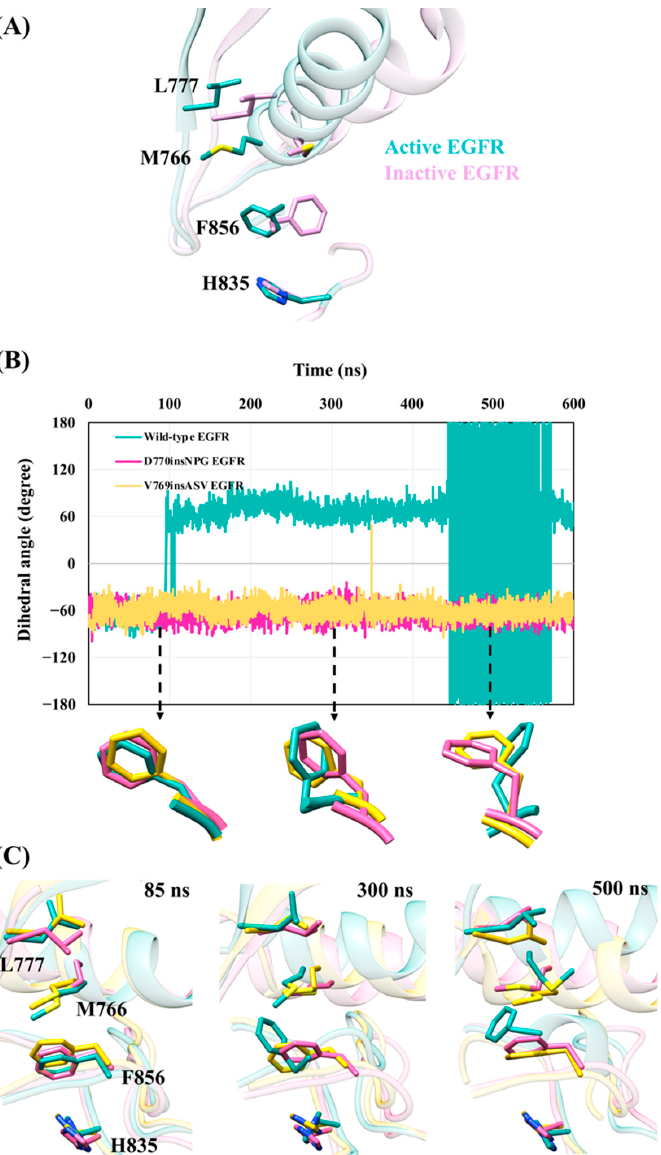
Figure 8. The insertion mutants appear to maintain the orientation of phenylalanine (Phe856) of the DFG motif and stabilize the R-spine of the EGFR active state. ( A ) Superimposed active and inactive conformations of the EGFR kinase with residues of the R-spine highlighted. ( B ) The χ 1 dihedral angle of Phe856 of the DFG motif during the simulations of wild-type, D770insNPG and V769insASV EGFRs. The χ 1 angles of the Phe856 side chain during the simulations of the